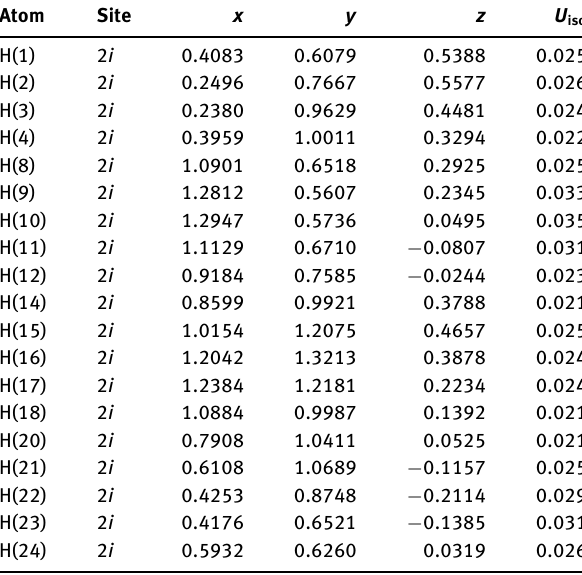
Table 2: Fractional atomic coordinates and isotropic or equivalent isotropic displacement parameters (Å 2